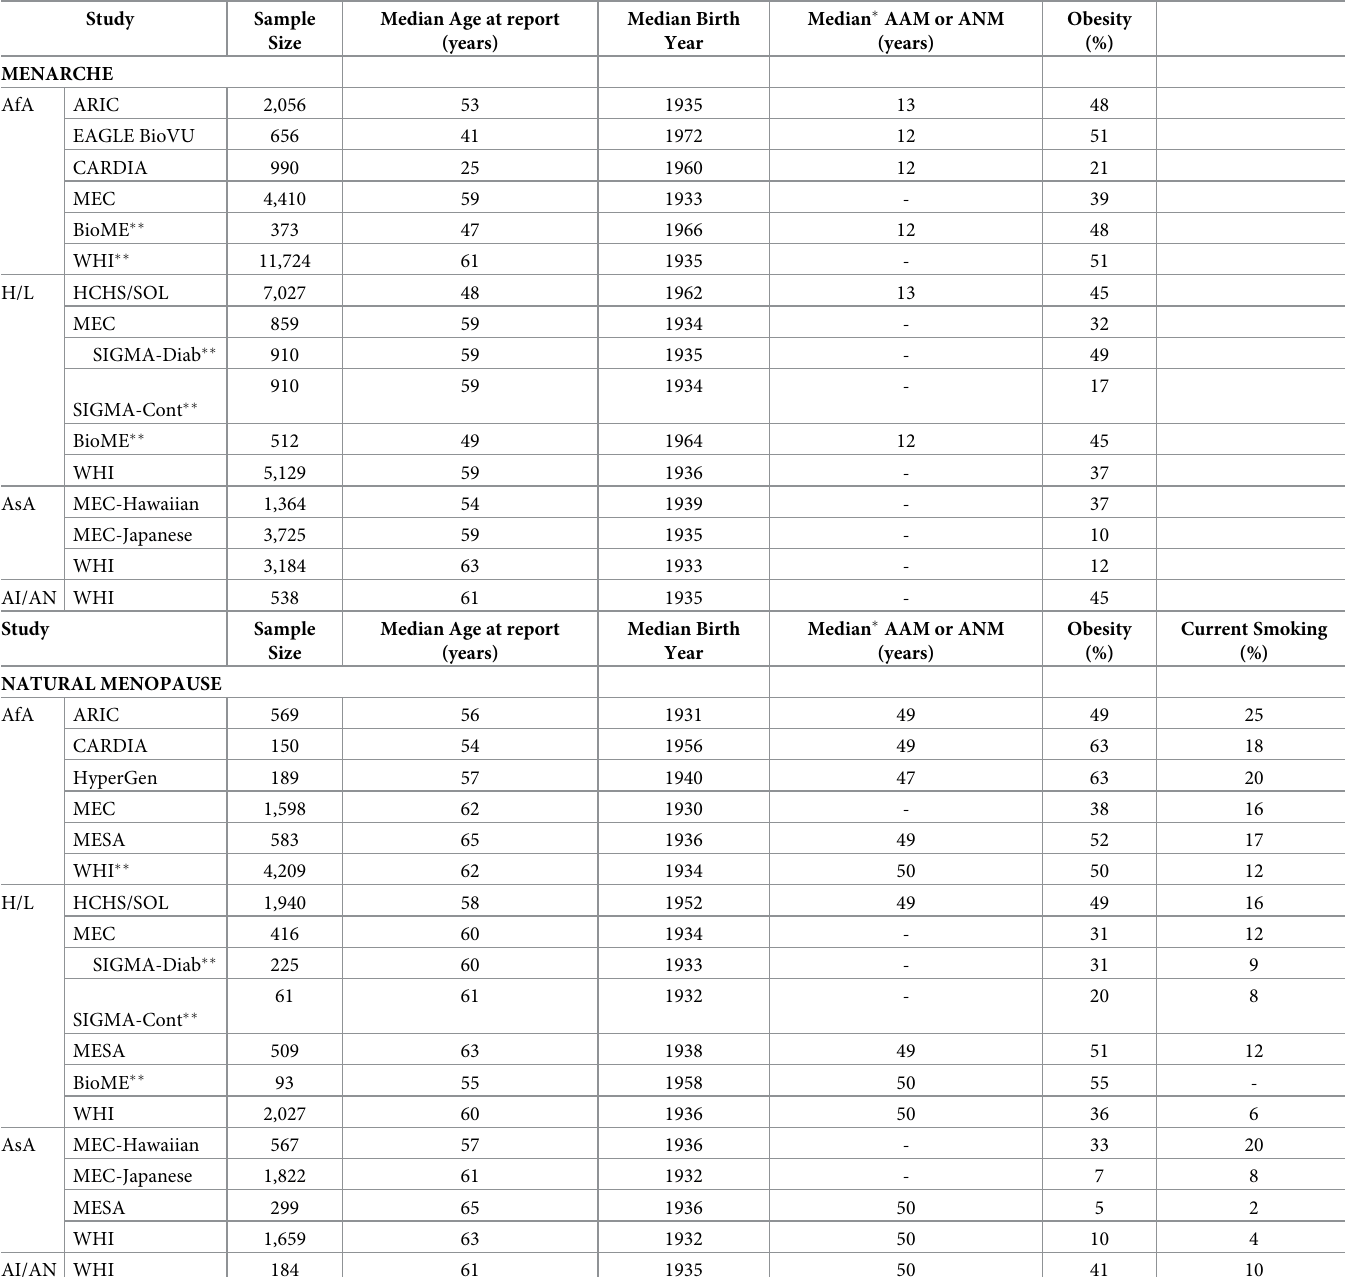
Table 1. Descriptive statistics for the age at menarche (AAM, n = 44,367) and natural menopause (ANM, n = 17,100) analytic samples.